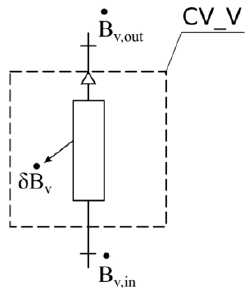
Figure 6. Exergy model for minor head loss (valves).